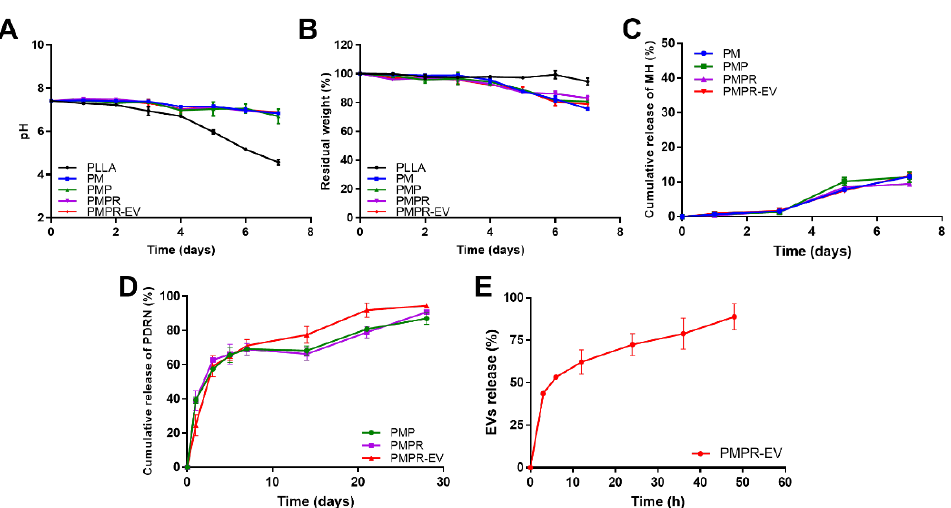
Figure 3. Degradation and release behavior of the composites. ( A ) The pH value, ( B ) residual weight, and ( C ) cumulative release of MH of the composites during accelerated degradation in PBS solution with protease K at 37 °C for 7 days. Cumulative release of ( D ) PDRN and ( E ) EVs in the composites for 28 days.